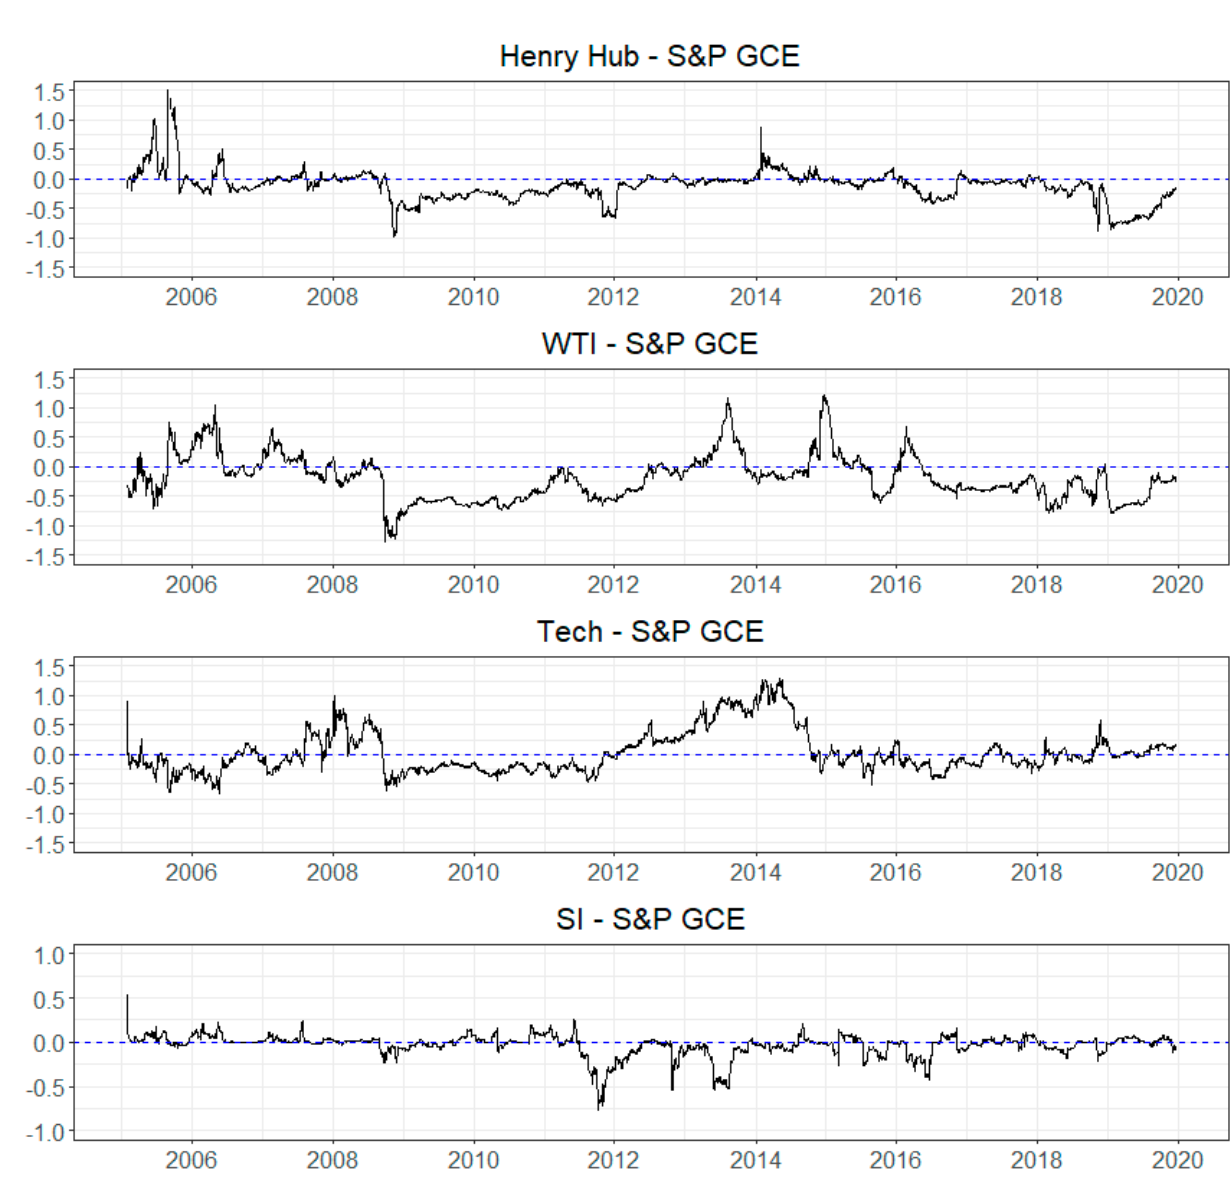
Figure A2. Dynamic net pairwise directional return connectedness (S&P GCE). Note: S&P GCE indicates Standard & Poor Global Clean Energy Index; Henry Hub indicates Henry Hub Natural Gas Futures; WTI indicates West Texas Intermediate Crude Oil Futures; Tech indicates NYSE Arca Tech 100 Index; SI indicates investor sentiment index.